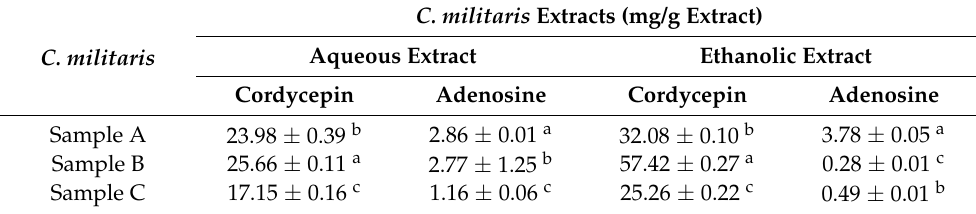
Table 3. Cordycepin and adenosine contents of C. militaris extracts.